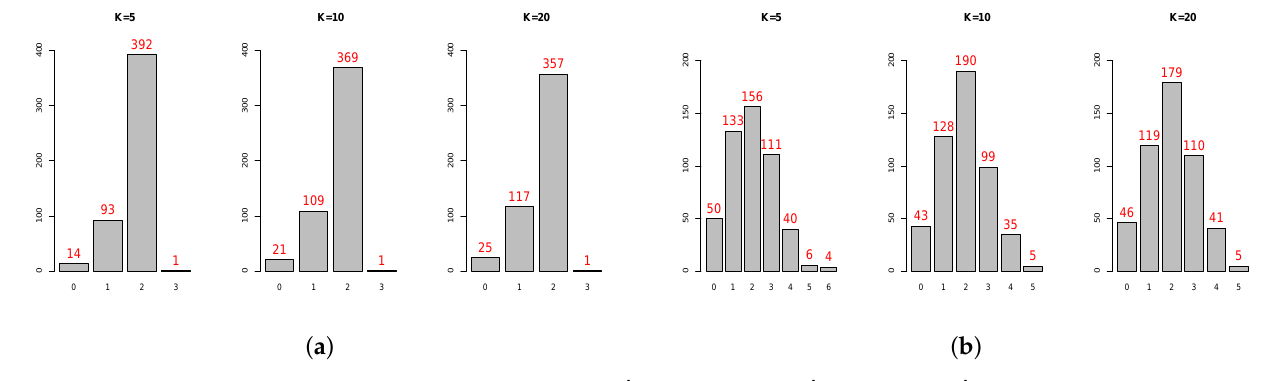
Figure A3. Boston Housing Price: | S (cid:53) ˆ S | ; S = var min , ( a ) ˆ S = var min ; ( b ) ˆ S = var 1 se .